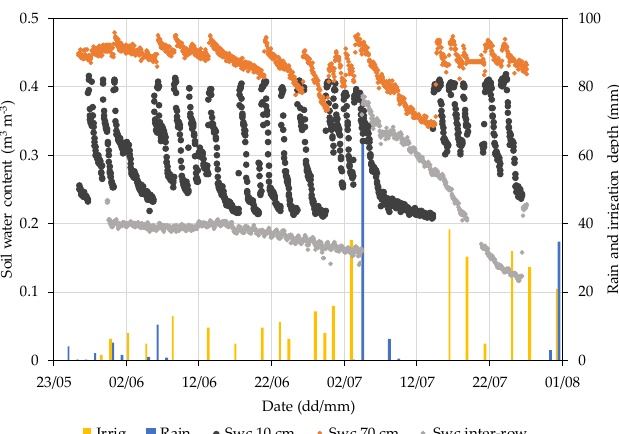
Figure 4. Hourly values of soil water content (SWC) by time domain reflectometry (TDR) probes horizontally and vertically installed at depths of 10 and 70 cm and in the middle of inter-row space. Daily rain and irrigation are also reported (from [36]).